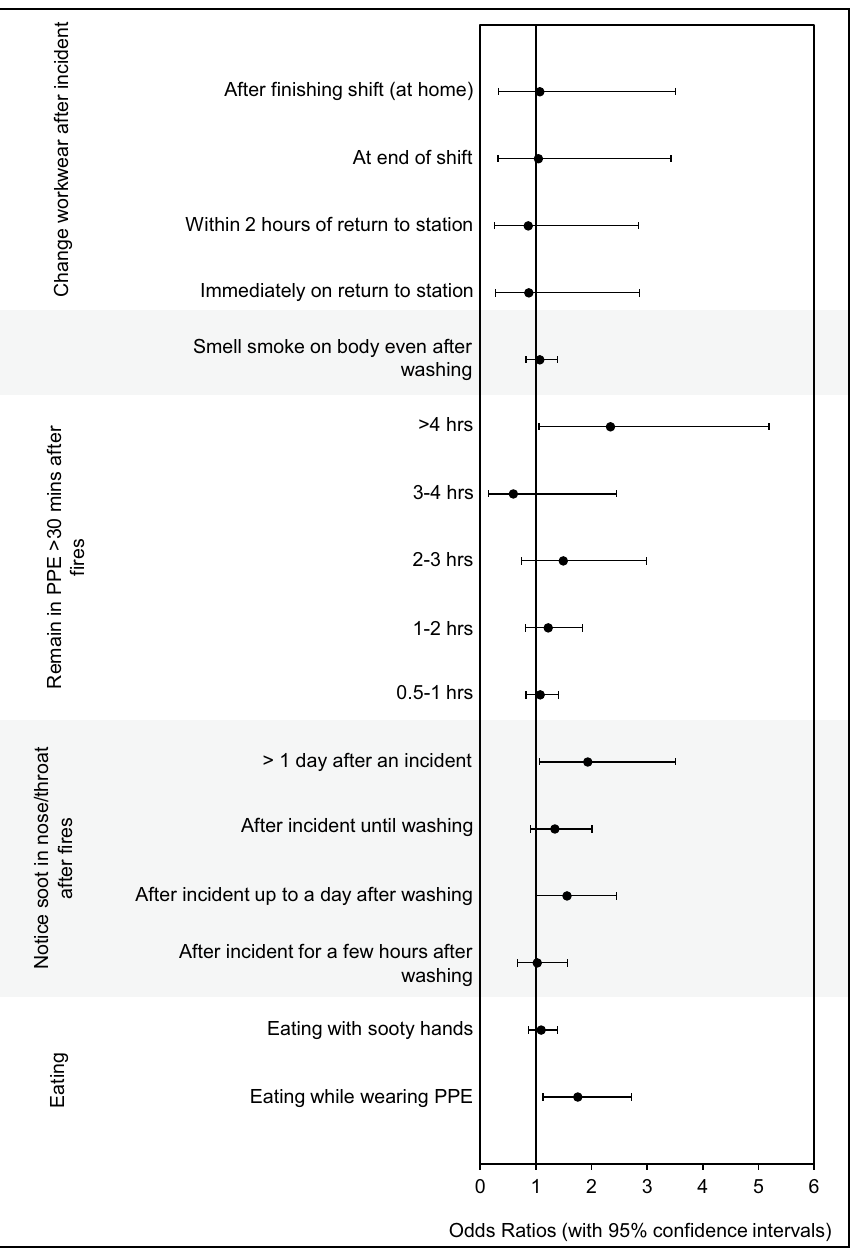
Figure 4. Personal contamination and cancer odds ratios for UK Firefighters. Odds ratios (with 95% confidence intervals) were adjusted for